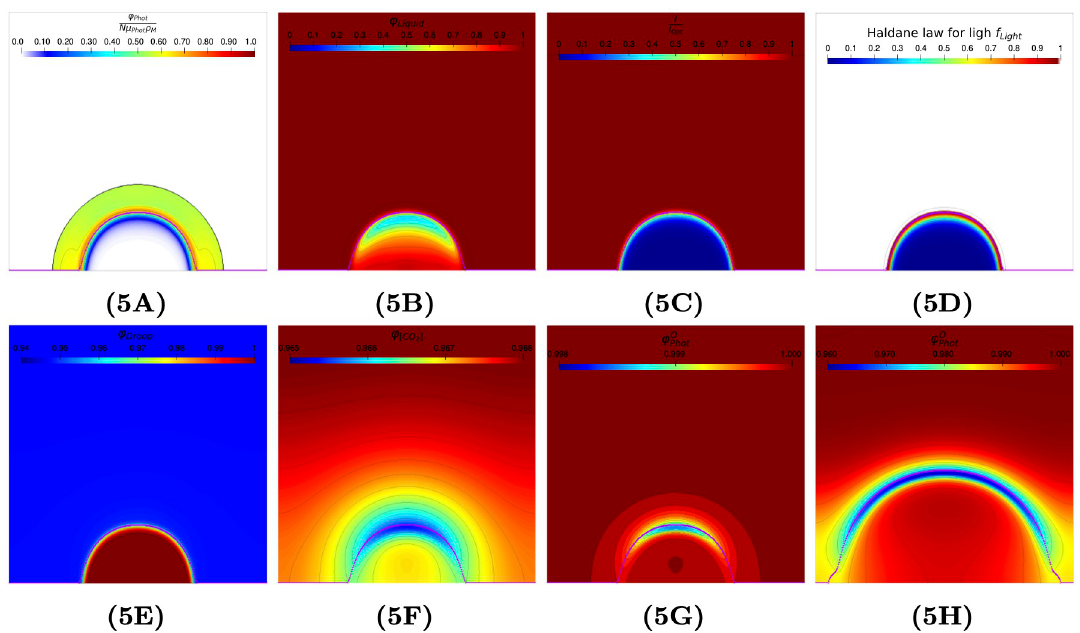
Fig 5. Relative contributions to photosynthesis rate of different terms considered at time t = 15 days (except Fig 5H at time t = 30 days); see S2 Text for the expression of these terms. Fig 5A: Normalized photosynthesis rate φ Phot . Fig 5B: Photosynthesis limitation N m Phot r M by liquid f Liquid . Fig 5C: Relative light intensity ^ I . Fig 5D: Photosynthesis limitation by light f Light using Haldane law. Fig 5E: Photosynthesis limitation by functional biomass quota f . Fig 5F: Photosynthesis limitation by inorganic carbon f . Fig 5G: Droop ½ CO 2 � Photosynthesis limitation by oxygen f at time t = 15 days. Fig 5H: Photosynthesis limitation by oxygen: f at time t = 30 days. Oxy Oxy